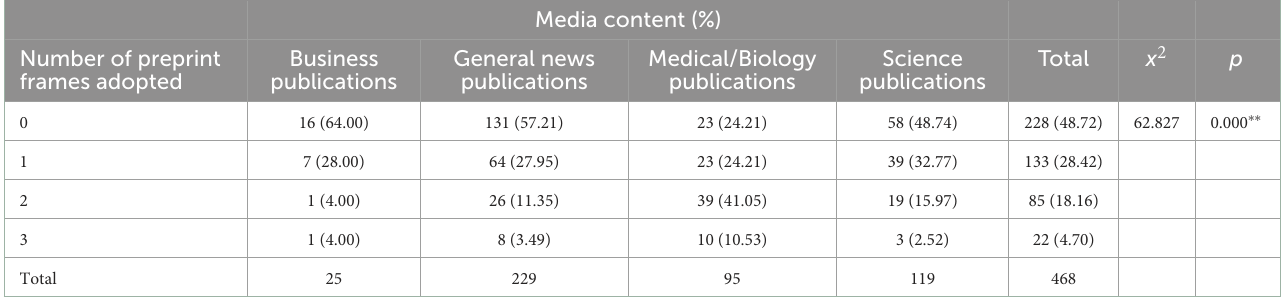
TABLE 7 Chi-square test (cross-tabulation) results for the media content and the number of preprint frames adopter. Media content